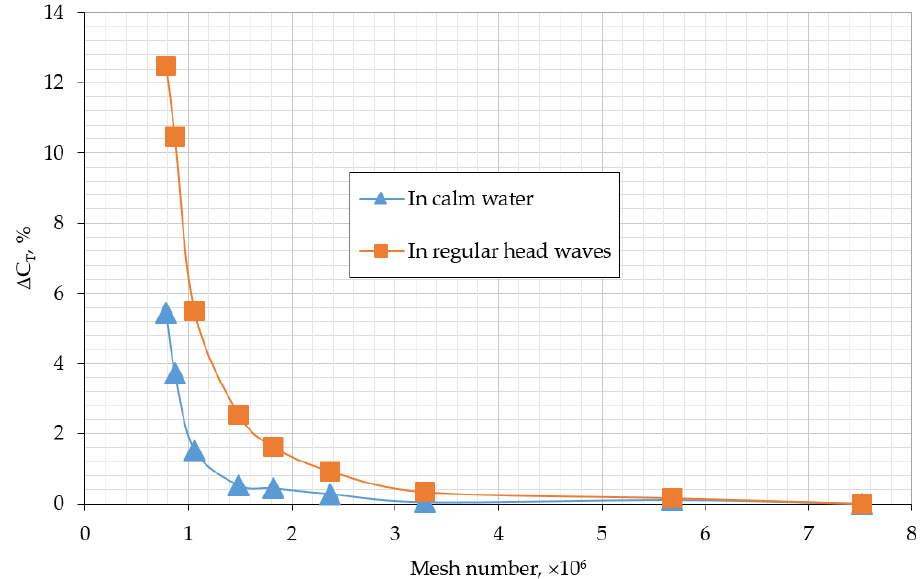
Figure 3. Effect of mesh number on CFD results of total resistance coefficient of the ship in calm water and in regular head waves at F n = 0.163, H w = 0.02 m, and λ /L pp =